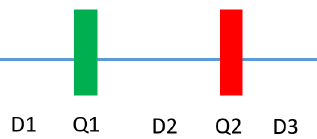
FIG. 1. Schematic plot of a FODO lattice in the first application example.